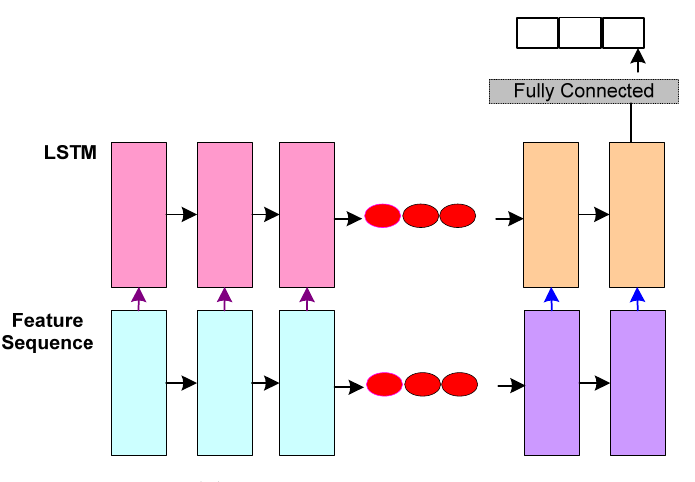
Figure 2. LSTM model.